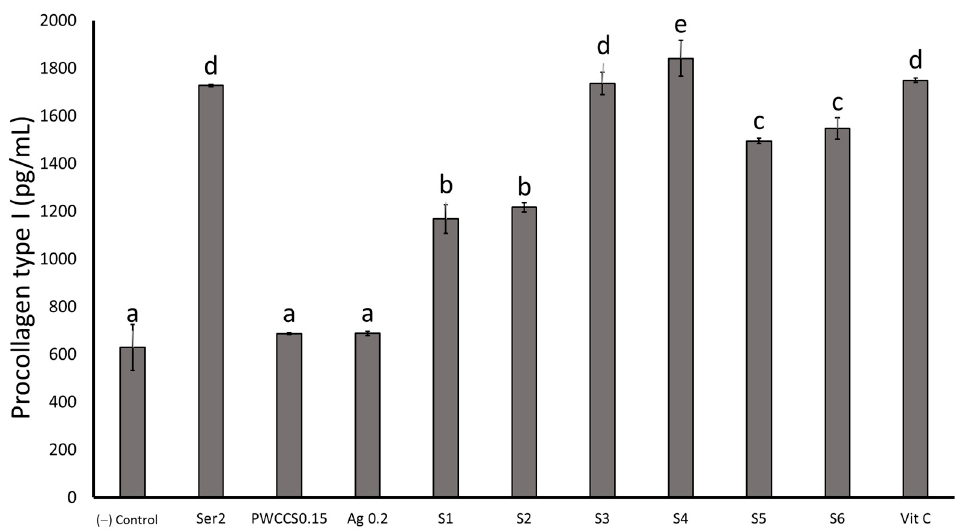
Figure 11. Procollagen type I content of 2% sericin (Ser2), 0.15% PWCCS(PWCCS0.15), 0.2% alginate (Ag0.2), ascorbic acid 25 µ g/mL (Vit C), S2, and S4 on the NHDF cells after 24 h. Data represent the mean ± SEM of the three replicates. Statistical significance was evaluated by Duncan’s post-hoc test; a–e letters indicate significant differences between the group at p < 0.05.